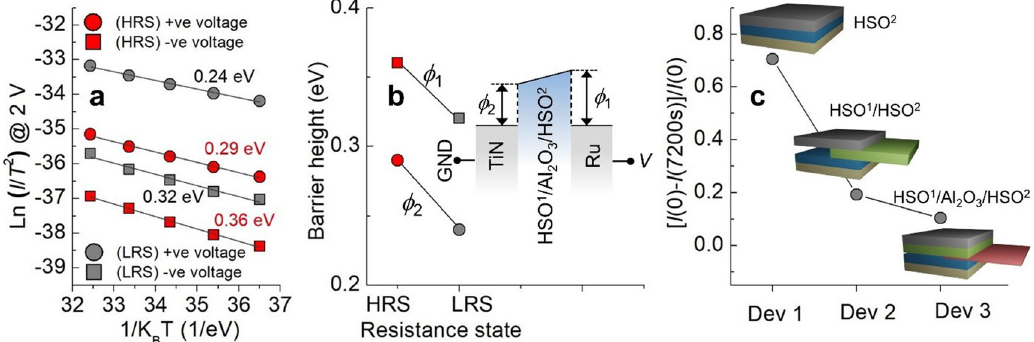
Fig. 3 Current behavior in temperature domain emission equation and data retention for SRMC devices. a Fitting Schottky emission equation to current measured at various temperatures (45 – 85 °C) and ±2 V for HRS and LRS. b Estimated barrier heights ( ϕ 1 and ϕ 2 ) indicated in inset for HRS and LRS. c Data retention for the proposed SRMC (Dev 3) at 85 °C compared with Dev 1 (Ru/HSO 2 /TiN) and Dev 2 (Ru/HSO 1 /HSO 2 /TiN). The as-programmed current level and current level at 7200 s are denoted by I (0) and I (7200 s),